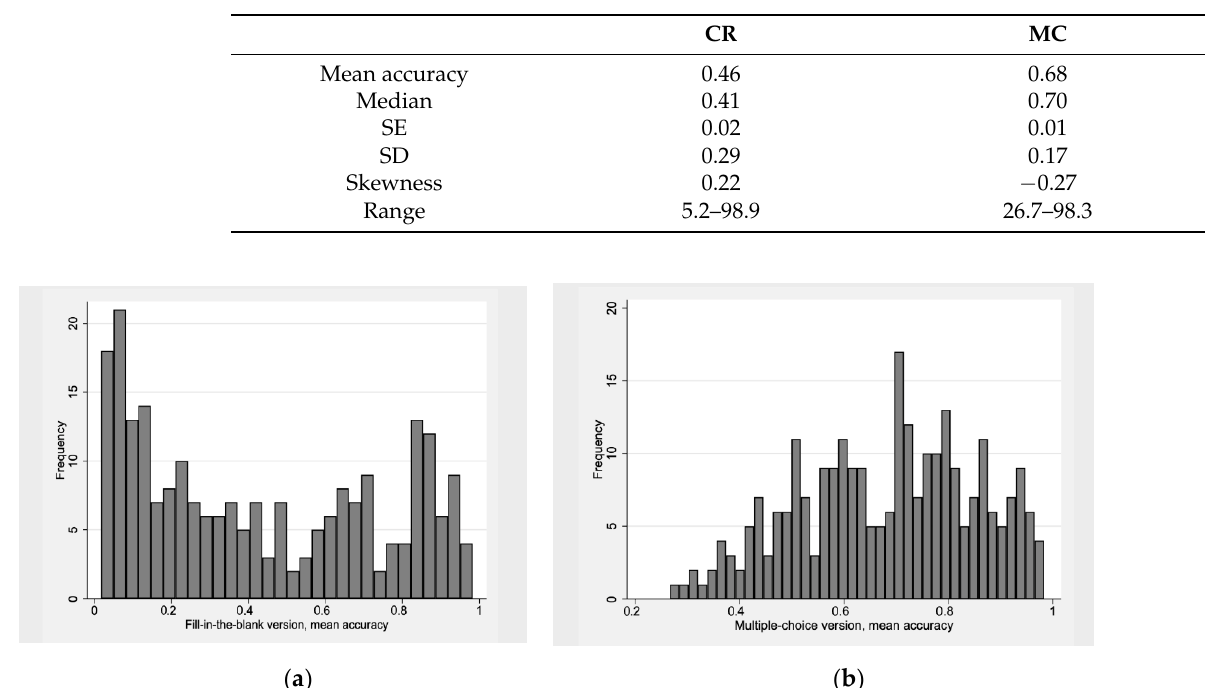
Table 5. Summary statistics of cloze test data.